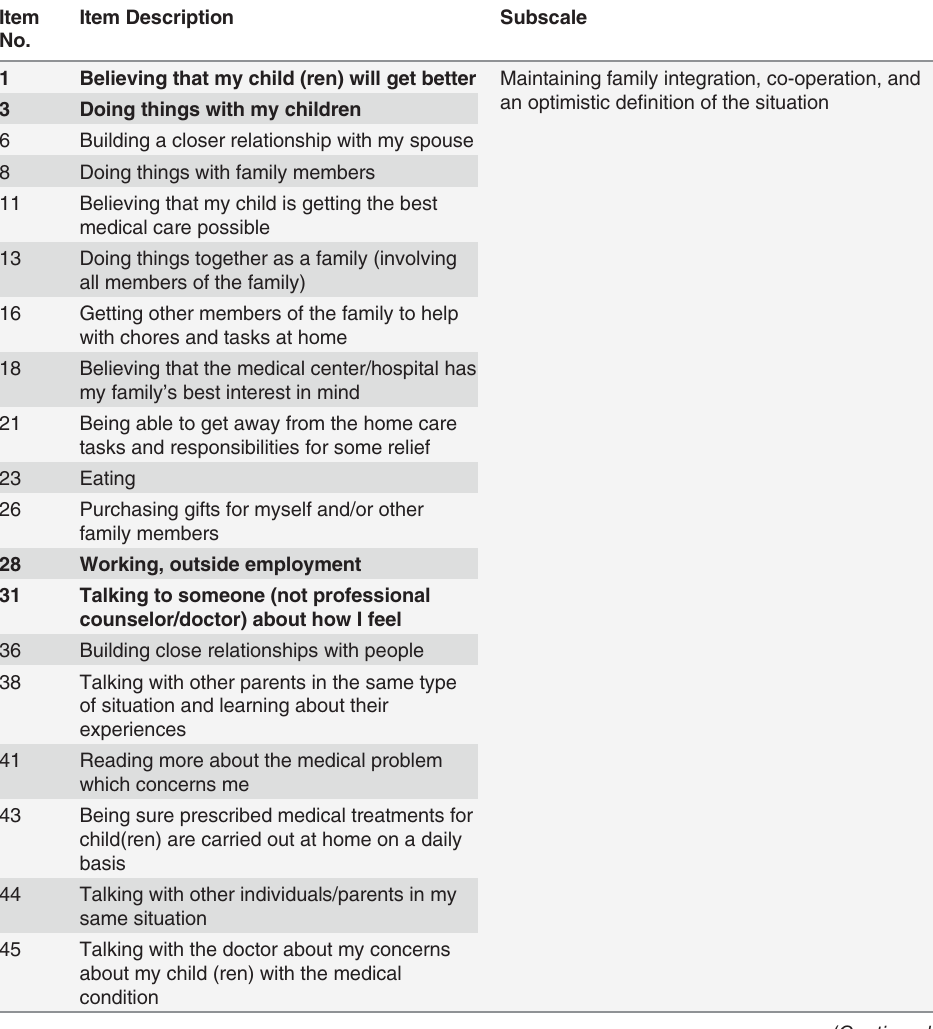
Table 1. Item content of the 45-item Coping Health Inventory for Parents (CHIP). Item